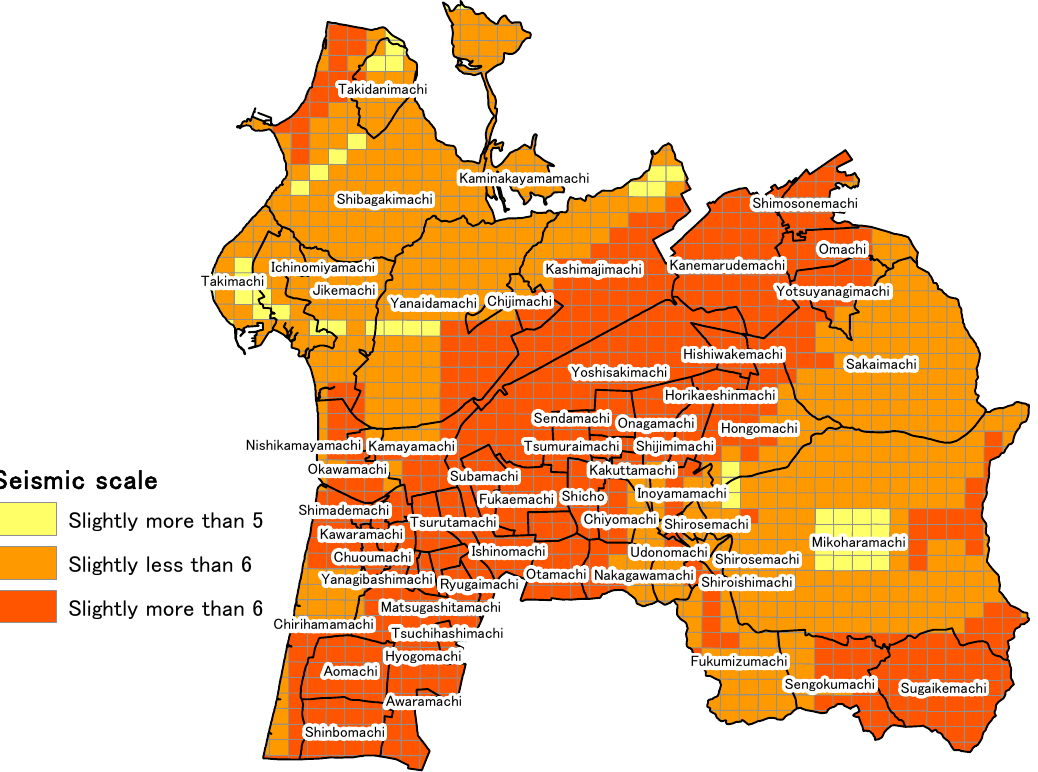
Figure 5. Visualizing the scale of the seismic intensity when an earthquake occurs in the Ochigata fault zone.